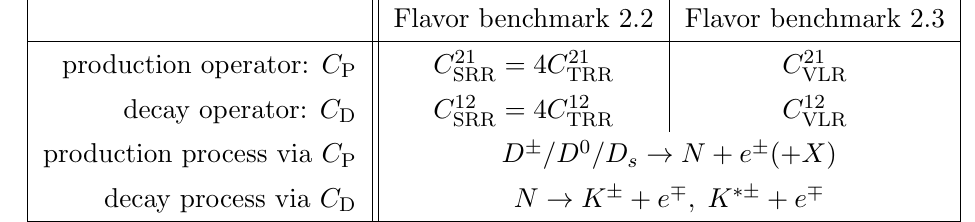
Table 4 . Summary of (cid:13)avor benchmark 2.